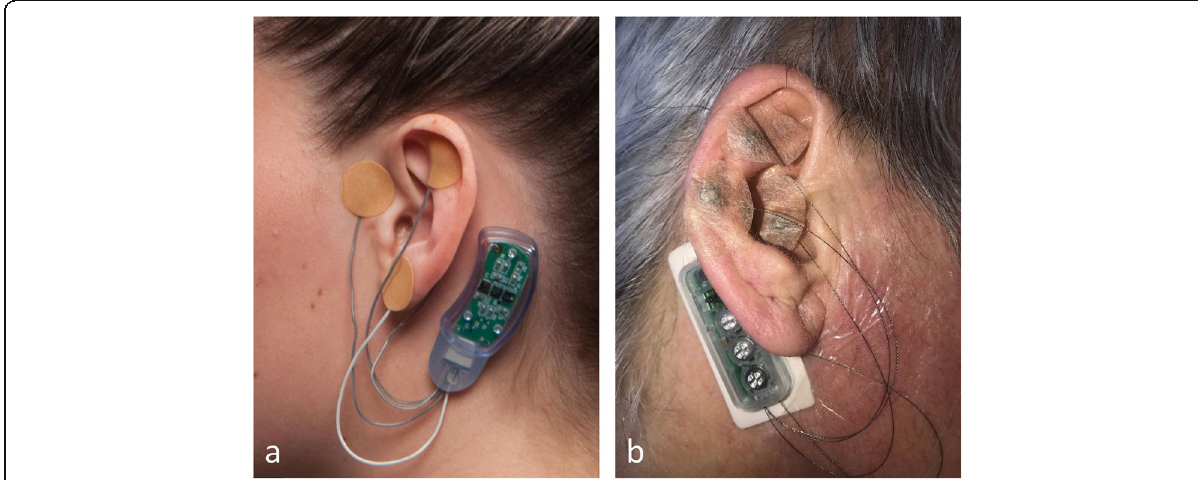
Fig. 1 a The NSS-2 Bridge device placed on the ear. The body of the device is placed behind the ear. The stimulating electrodes are connected via wires and placed at key points on the ear. Each electrode contains a short penetrating needle which is used to provide percutaneous electrical stimulation. Source: Forbes.com: (source) b The DyAnsys Drug Relief stimulator place on the ear. The device is similar in construction to the NSS-2 Bridge device which served as the predicate for its approval.